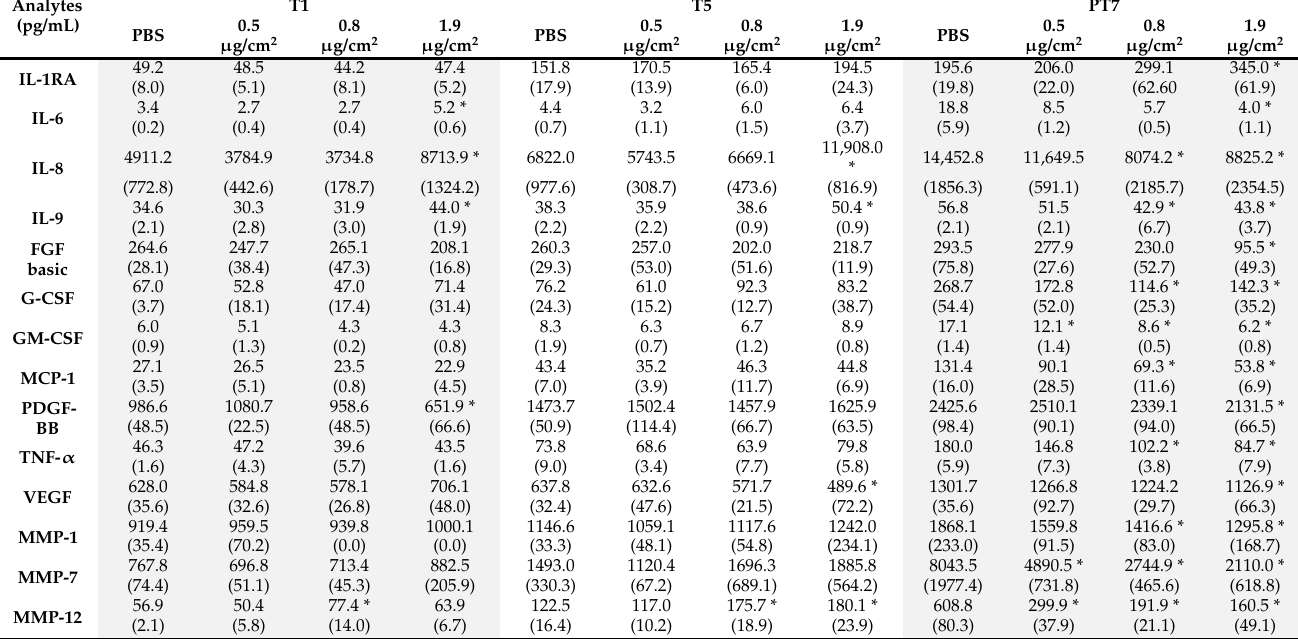
Table 1. Modulation of cytokine and MMP secretion by GA aerosols in ALI